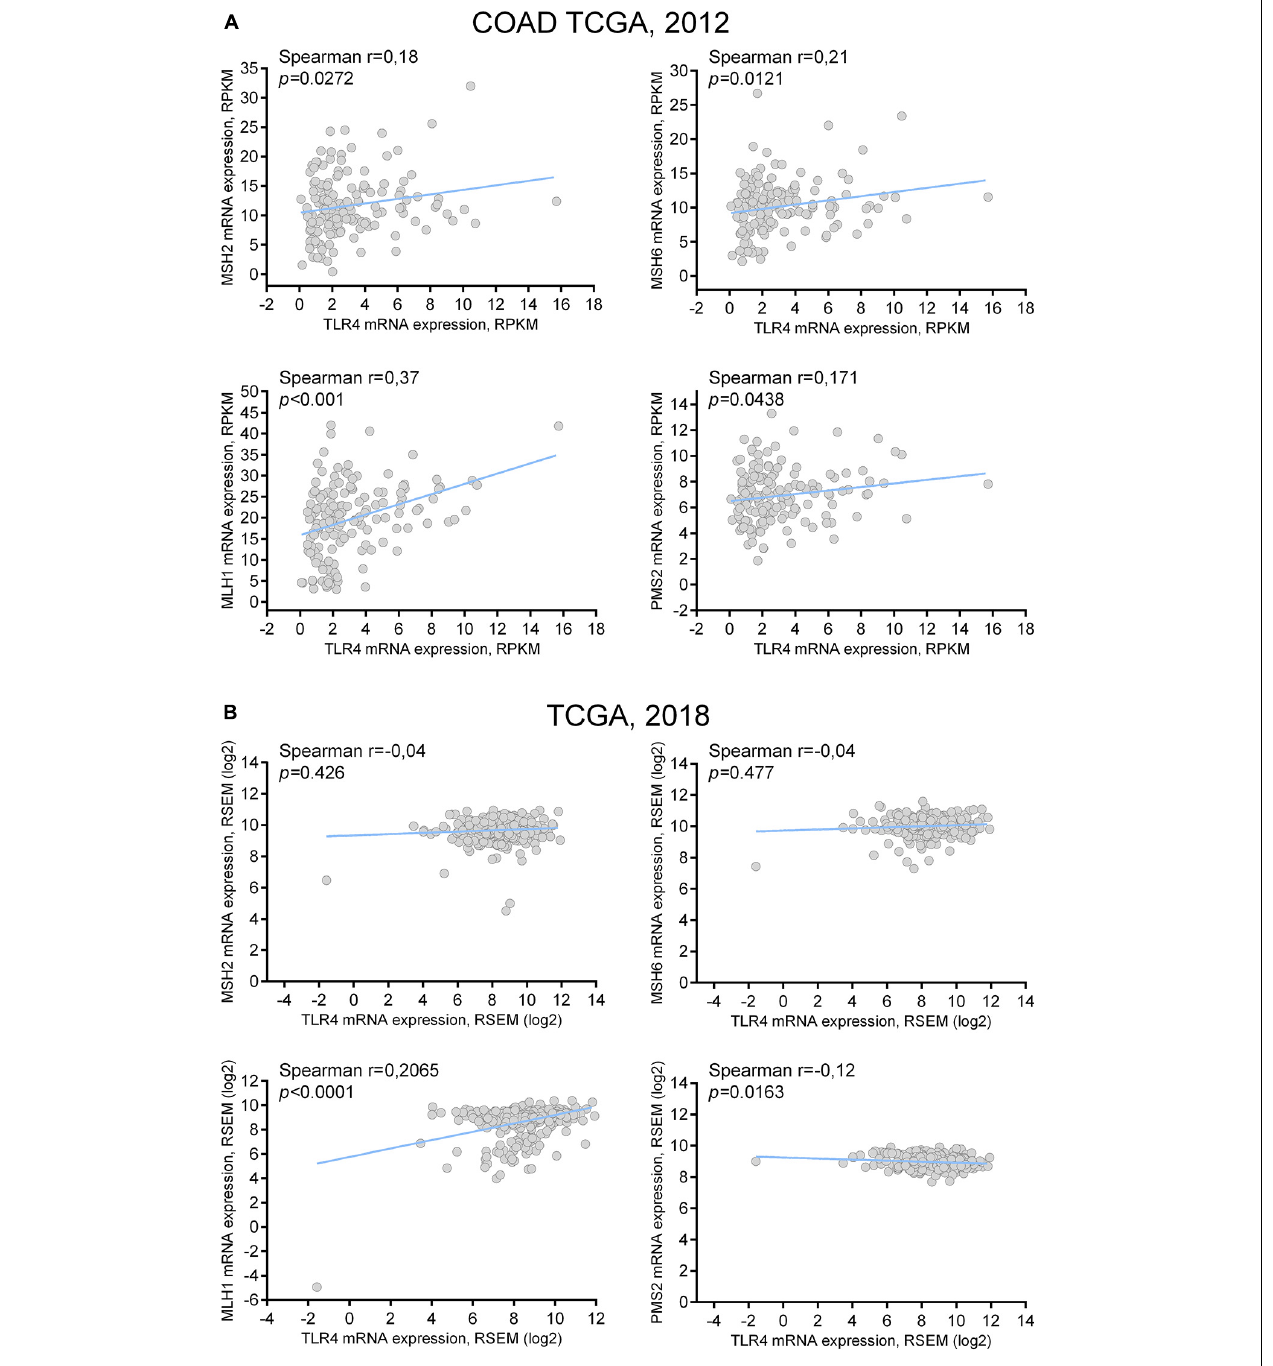
FIGURE 3 | TLR4 mRNA coexpression analysis with MMR genes: correlation with MLH1. (A) TLR4 mRNA coexpression analysis with MSH2, MSH6, MLH1, and PMS2 mRNA in tumor samples of COAD TCGA dataset. (B) TLR4 mRNA coexpression analysis with MSH2, MSH6, MLH1, and PMS2 mRNA in tumor samples of TCGA PanCancer Atlas